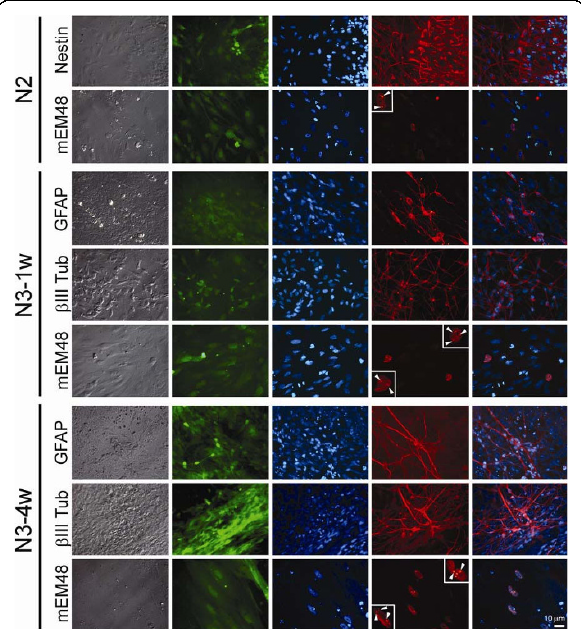
Figure 3 Immunocytochemical analysis of in vitro differentiated TrES1 . TrES1 was differentiated toward neuronal lineage in vitro using a step-wise differentiation protocol. Antibodies specific for neural progenitor cells (nestin), glial fibrillary acidic protein (GFAP), and mutant htt (mEM48) were used for immunostaining at different differentiation stages: N2, N3-1 week (N3-1w), and N3-4 weeks (N3- 4w). At N2 stage, all cells were stained with Nestin and some were stained positive with mEM48. At N3-1w and N3-4w, cells were stained with GFAP, b III-tubulin and mEM48. First column-brightfield images; second column-epifluorescent images of GFP; third column- DNA staining with Hoechst; fourth column-immunostaining with specific antibodies, and fifth column-overlay images of the third and fourth columns. Insets are images of selected nuclei with nuclear inclusions at higher